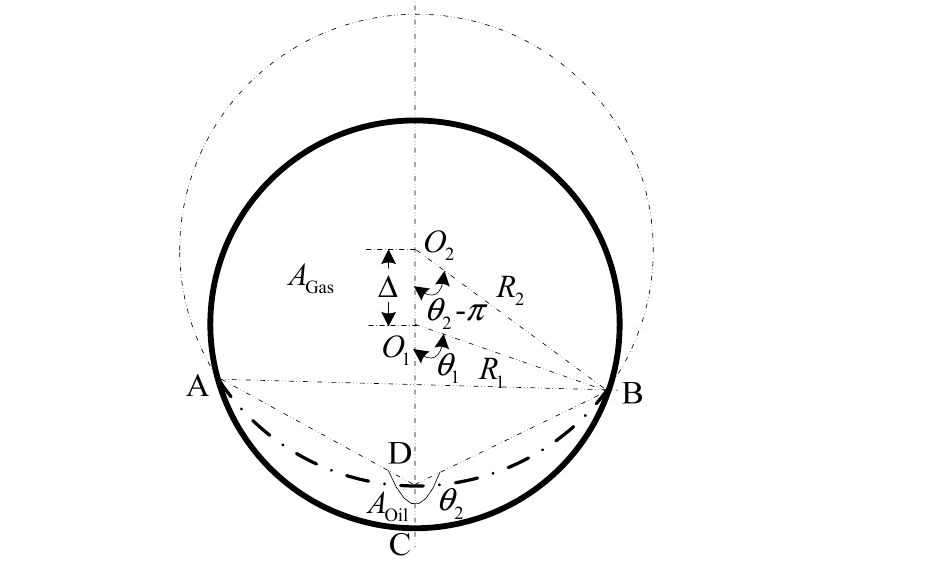
Figure 3. Geometrical relationship of concave interface.